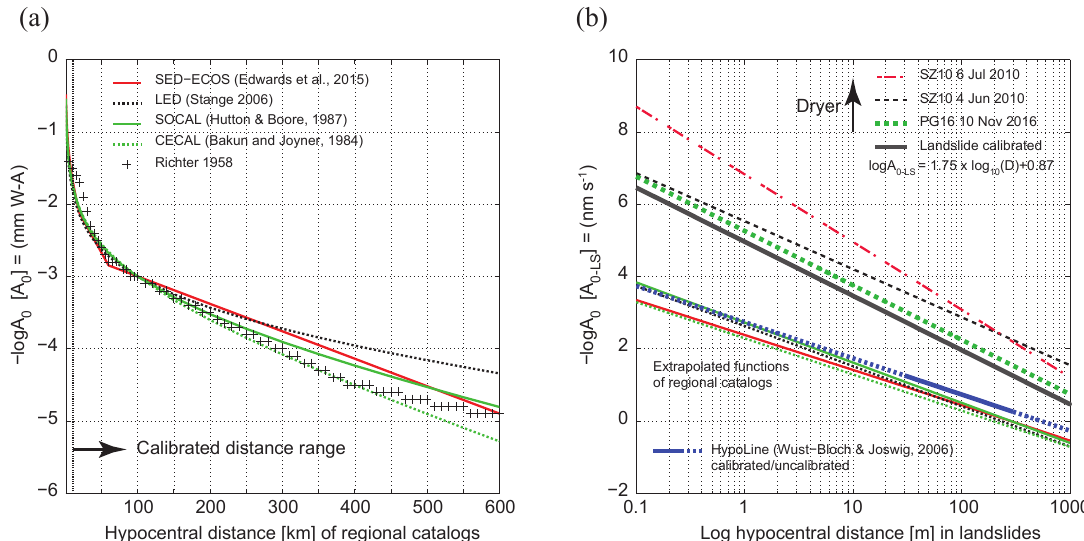
Figure 12. (a) Distance attenuation functions ( − log( A 0 )) of M L scales empirically calibrated for regional earthquakes with source–receiver distances between 10 and 600–1000km. (b) Log–log zoom in of the valid source–receiver distance range of microseismic observations at clayey landslides. The HypoLine distance attenuation function, which was calibrated between 30 and 300m in the Dead Sea valley (Wust- Bloch and Joswig, 2006) is very similar to the projection of the regional M L scales. The distance attenuation regression curves derived from the SISSY calibration shots and hammer blow data (see Fig. 11) project into the upper area of the graph, all with steeper slopes (displaying stronger attenuation) than the regional M L scales. The landslide calibrated distance attenuation function applies an average slope of 1.75 with an intercept of 0.87. Note that regional M L scales use displacement amplitudes in WA in millimeters, whereas M L − LS scale is calibrated using velocity readings in nanometers per second; hence a direct comparison of these curves is not straightforward. Discussion is found in Sect.